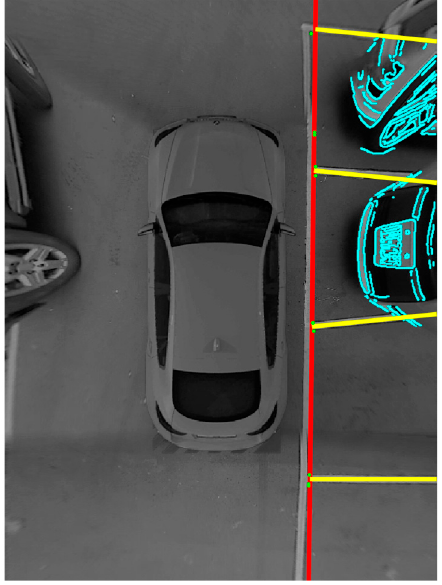
Figure 16. Obstacle feature extraction.